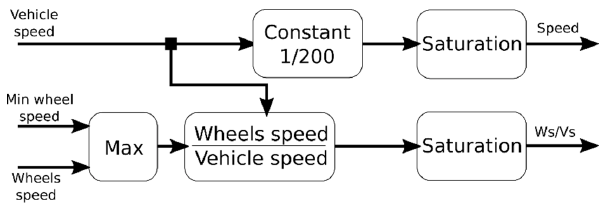
Figure 5. Block scheme of ABS control with fuzzy controller.